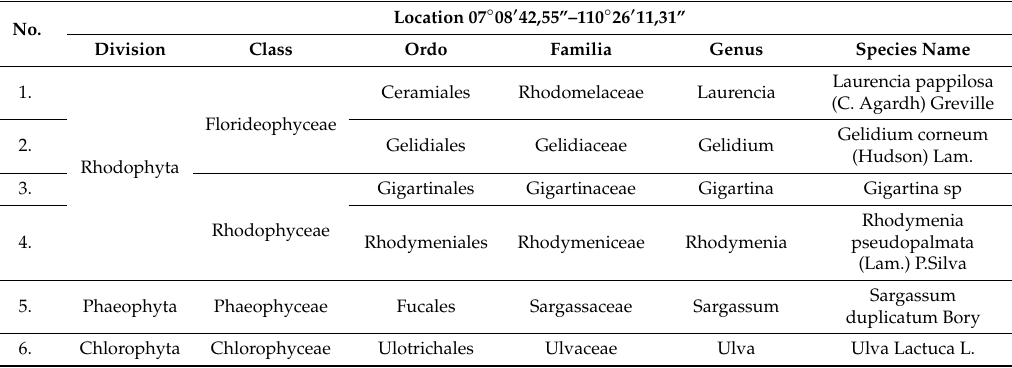
Table 3. Algae species taxonomy surrounded